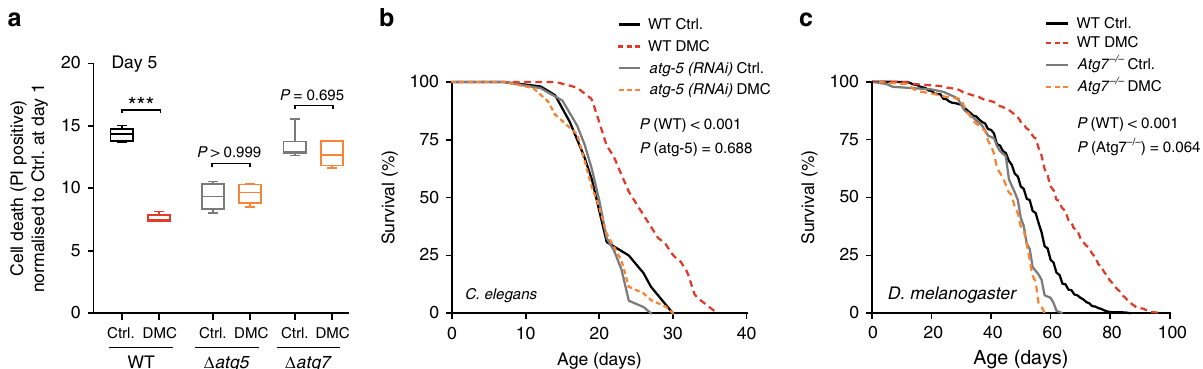
Fig. 4 Autophagy induction is essential for 4,4 ’ -dimethoxychalcone-mediated protection. a Survival of DMC-treated (100 µ M) yeast wildtype (WT), ATG5-de fi cient, and ATG7-de fi cient mutant strains at day 5 of chronological ageing measured by PI staining. Data are normalised to the WT Ctrl. at day 1. Comparisons by two-way ANOVA with treatment and strain as independent variables, followed by Bonferroni-corrected simple main effects. *** P < 0.001, n = 6 independent biological replicates. Box plots represent IQR (line at median) and whiskers 10 – 90 percentile. Refer to Supplementary Figure 7 for other time points and other replicate experiments. Source data for ( a ) are provided as a Source Data fi le. b , c Survival of DMC-fed (41.6 µ M) control and autophagy-de fi cient Atg5 RNAi nematodes ( b ) or female wildtype (WT) and Atg7-de fi cient (Atg7 − / − ) mutant fl ies ( c ) during ageing. Refer to Supplementary Figure 7 for other replicate experiments. P -values represent pairwise comparisons (Ctrl. vs. DMC) by log- rank